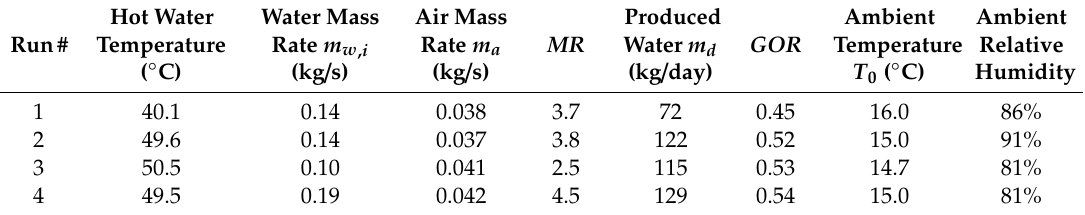
Table 2. Experiment data of some example runs with varying MR .